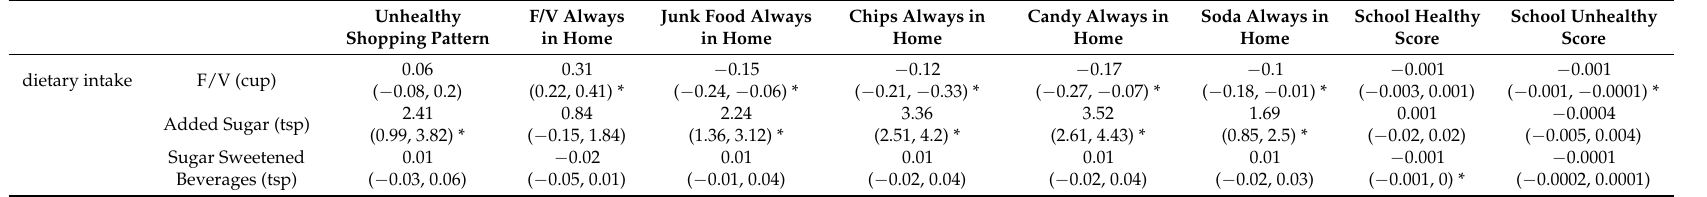
Table 3. Association between food shopping pattern and food environments with daily dietary intake, North Carolina and Kentucky, 2016.